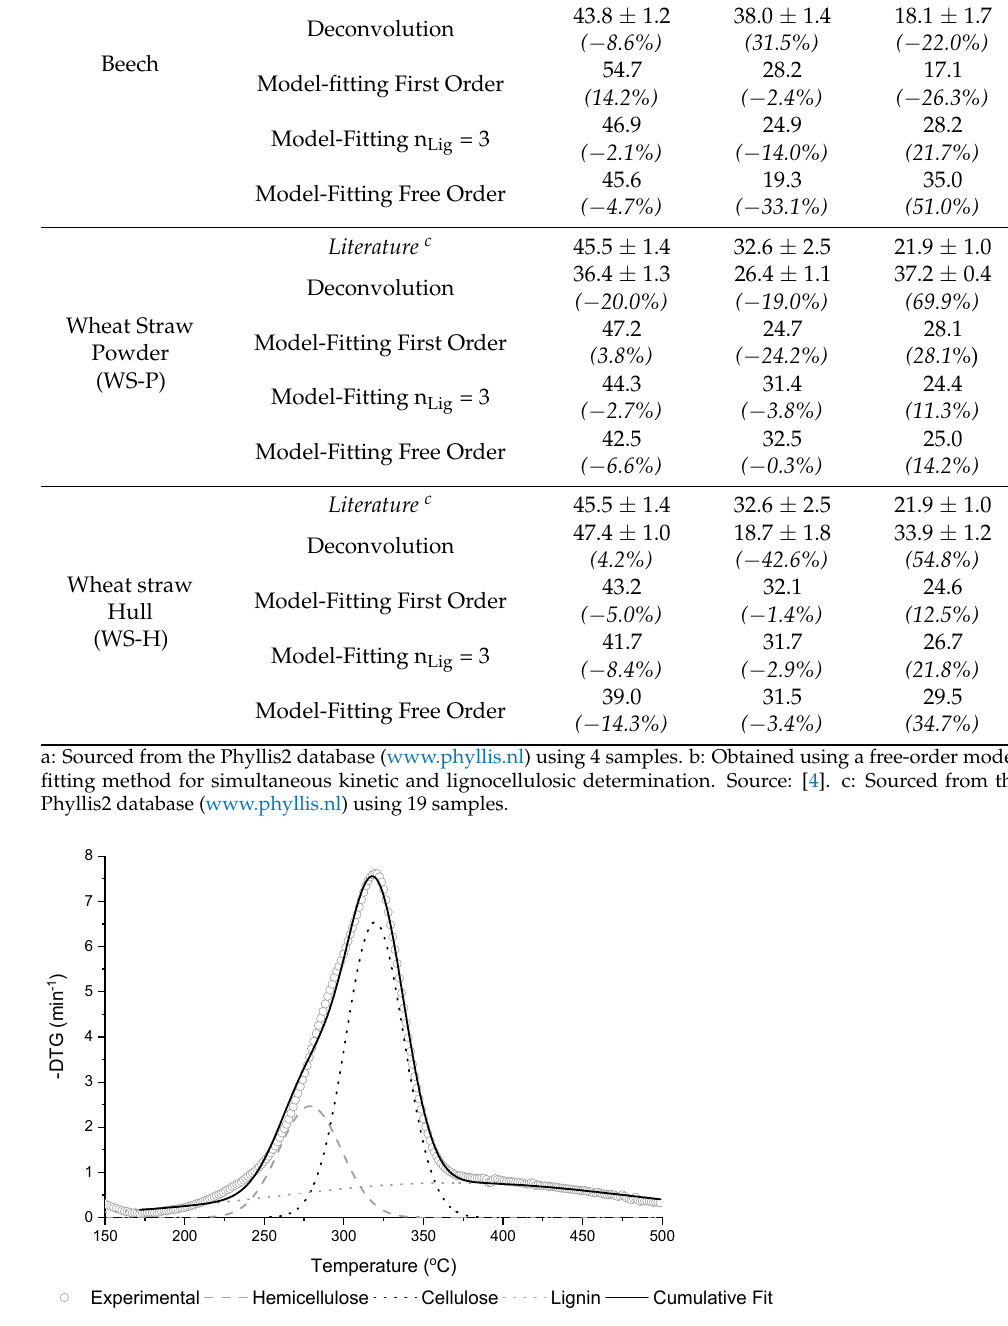
Figure 3. Example of deconvolution using Gaussian curves centered at the point devised by the DDTG method (see Table 5). WS-P, 10 K·min − 1 .